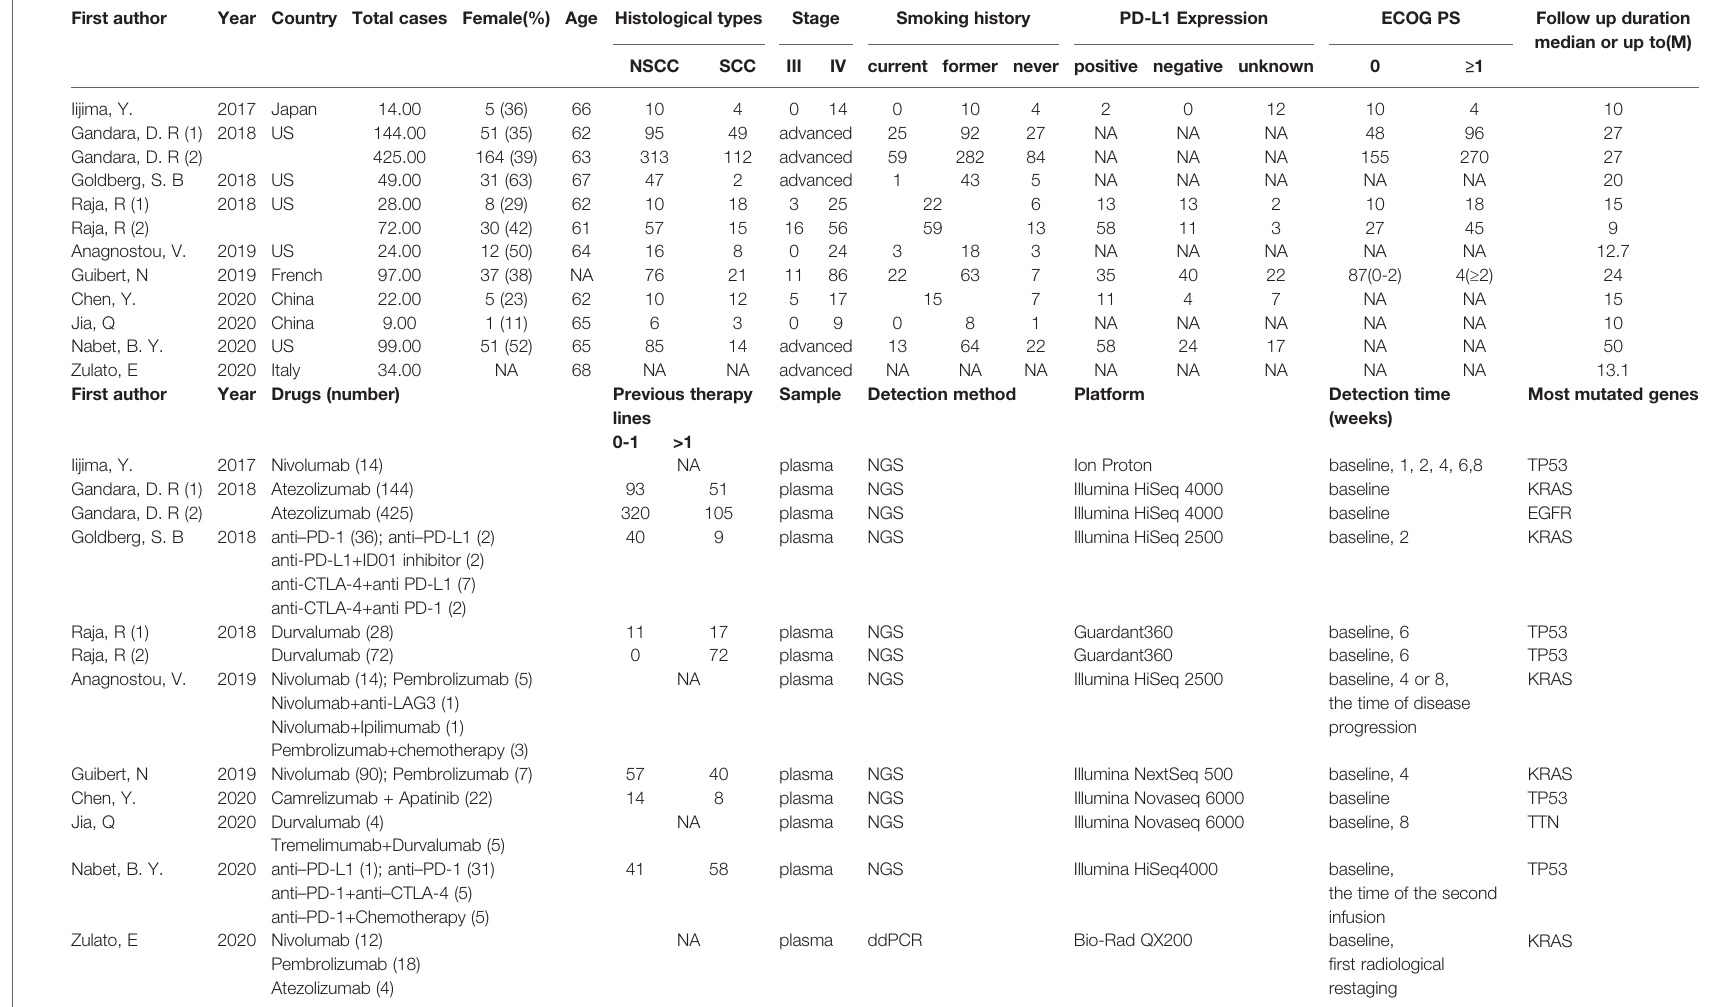
TABLE 1 | Basic characteristics of the included studies in the present